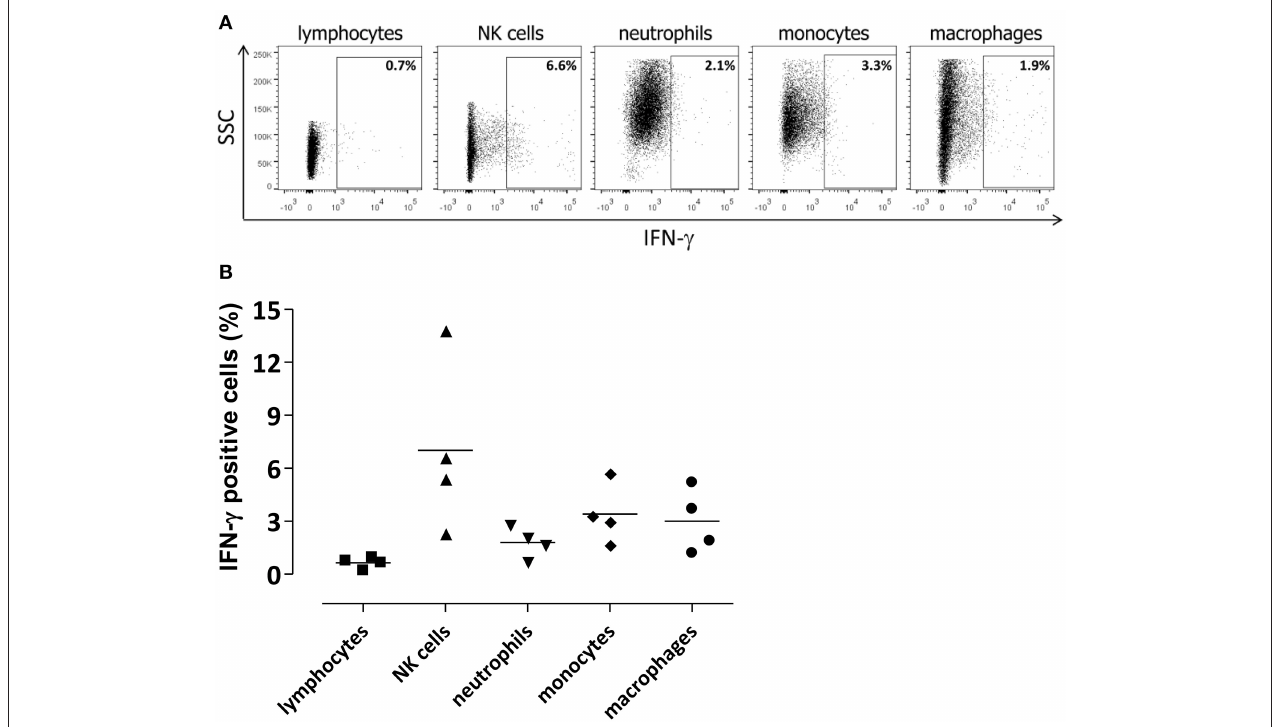
FIGURE 4 | Cellular source of IFN- γ in the infected brain. Lymphocytes (CD45 hi CD3 + ), NKs (CD45 hi CD3 − NKp46 + ), neutrophils (CD45 hi CD11b hi Ly6G + ), monocytes (CD45 hi CD11b hi Ly6G − Ly6C + ), and macrophages (CD45 hi CD11b hi F4/80 + ) were analyzed for IFN- γ intracellular staining. Flow cytometric analysis was performed in brain of mice 48h post intracranial infection with 3 × 10 4 CFU of S. pneumoniae TIGR4. (A) Representative flow cytometry dot plot graphs showing the percentage of IFN- γ + cells among different cell populations in the brain. The gate for IFN- γ + cells was set using an appropriate APC-conjugated isotype control. (B) Symbols represent individual mice and bars represent the mean. Mean values for each cell population were 0.6 ± 0.1% for lymphocytes, 7 ± 2.4% for NK cells, 1.8 ± 0.4% for neutrophils, 3.4 ± 0.8% for monocytes, and 3 ± 0.9% for